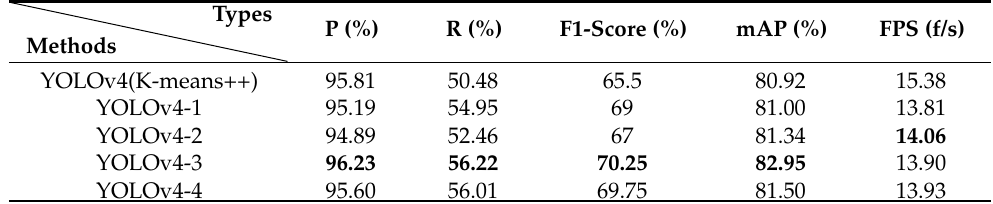
Table 3. Average P, R, F1-Score, and mAP of each